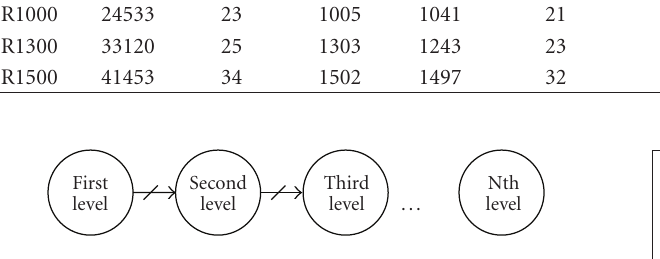
Figure 3: Reduced form after level